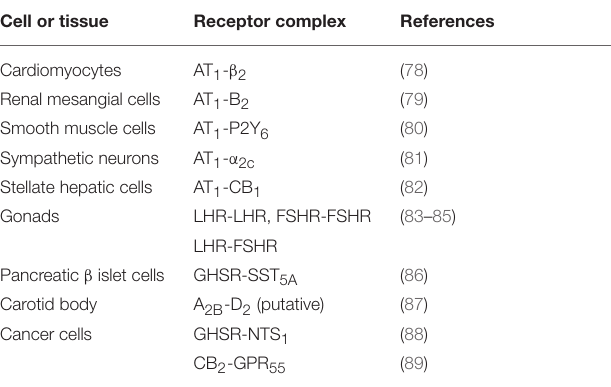
TABLE 1 | Examples of GPCR complexes in peripheral cells and